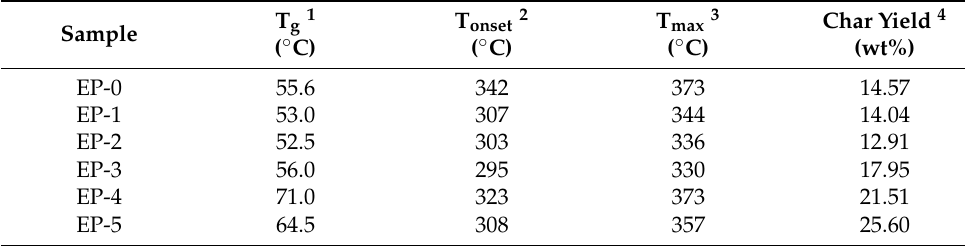
Table 2. Thermal properties of epoxy composites.